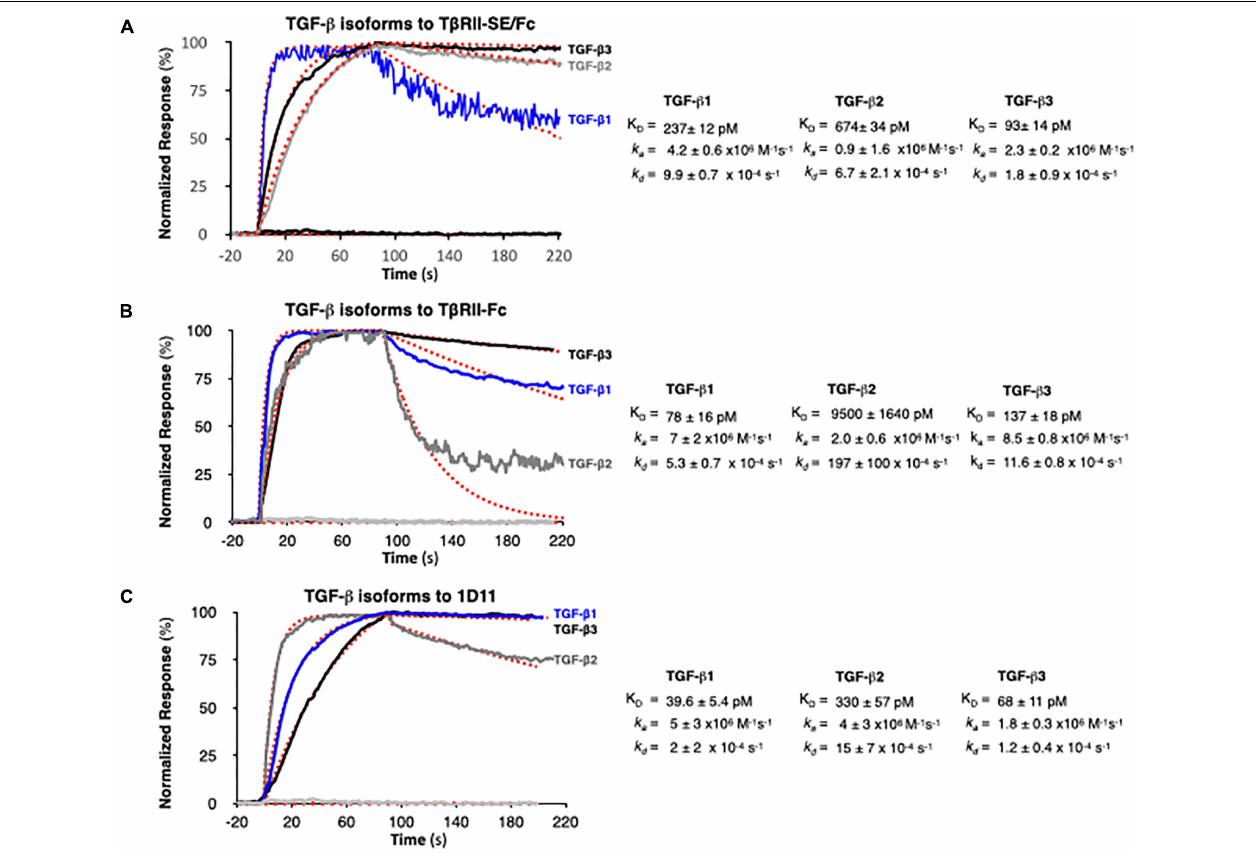
FIGURE 4 | SPR binding profiles of 30 nM TGF- β isoforms to Fc-captured recombinant T β RII-SE/Fc, T β RII-Fc, and 1D11 mAb. Normalized association ( t = 90 s) and dissociation profiles ( t = 130 s shown) for (A) T β RII-SE/Fc, (B) T β RII-Fc, and (C) 1D11 mAb complexes with each TGF- β isoform are shown overlayed with the respective global model fits (red dashed lines). Blue: TGF- β 1, gray: TGF- β 2, and black: TGF- β 3. Calculated kinetic parameters are shown to the right for each interaction.